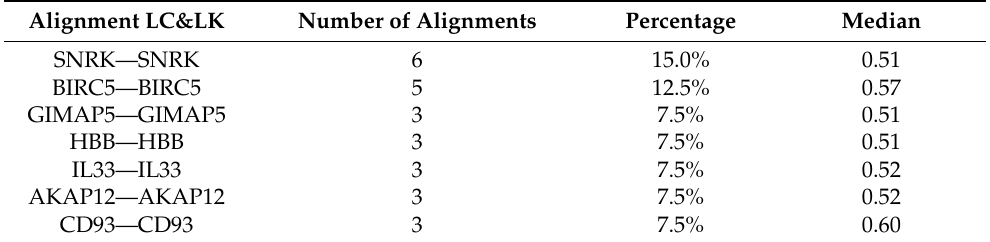
Table 4. Gedevo’s most significant alignments between lung cancer (LC) sets and leukemia (LK) sets. Alignment LC&LK Number of